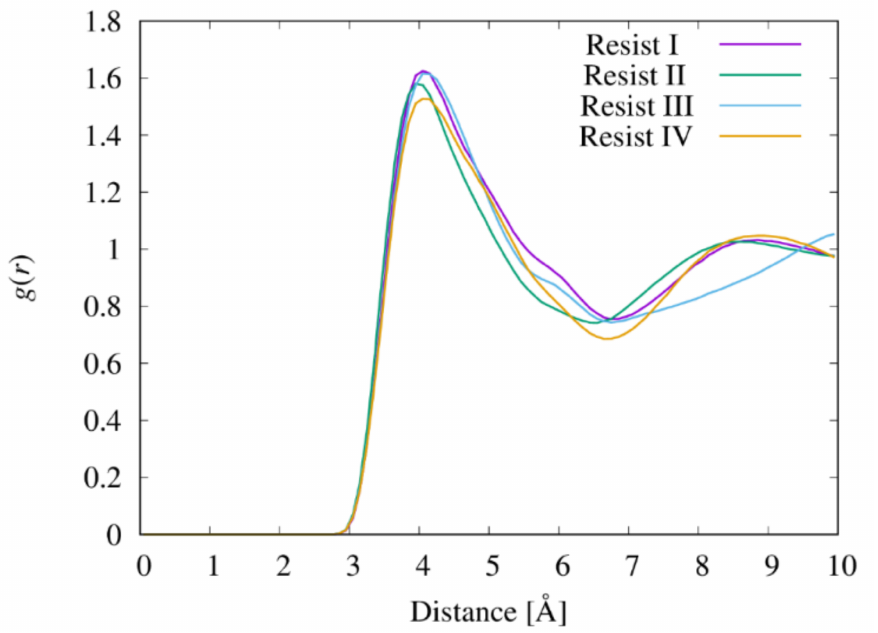
Figure 7. Radial distribution of the g ( r ) functions between the terminal carbon atoms of the acry- loyl/vinyl groups in the four resist materials. Only the intermolecular pairs of the carbon atoms were considered in the calculations of g ( r ).